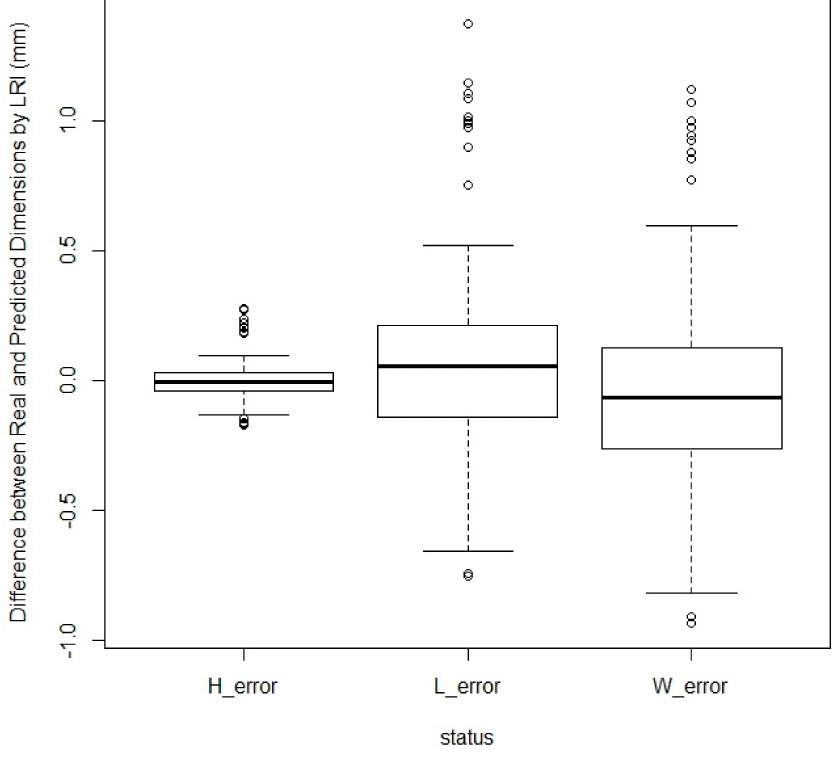
Figure 7. Difference between real and predicted CAD dimensions by LRI.